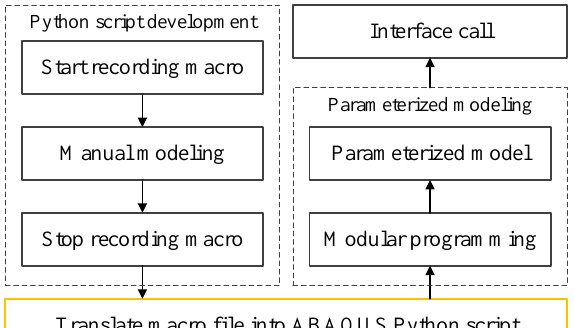
Figure 5. The improved parameterized modeling process.